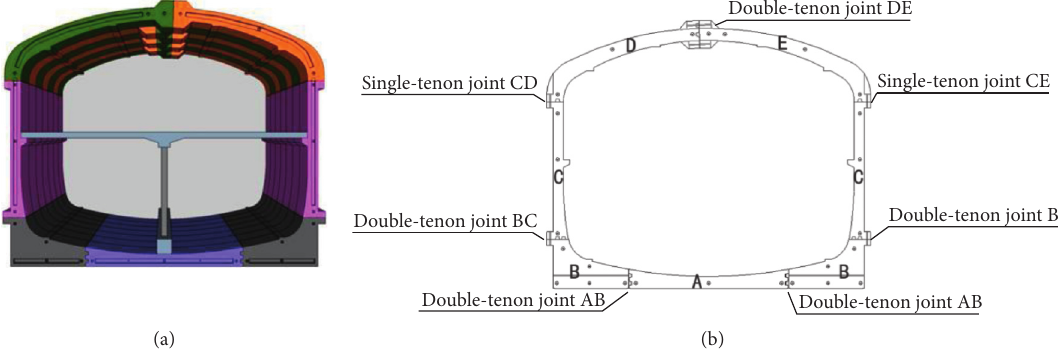
Figure 1: Cross section of prefabricated station structure on Changchun metro. (a) Prefabricated station structure. (b) Cross